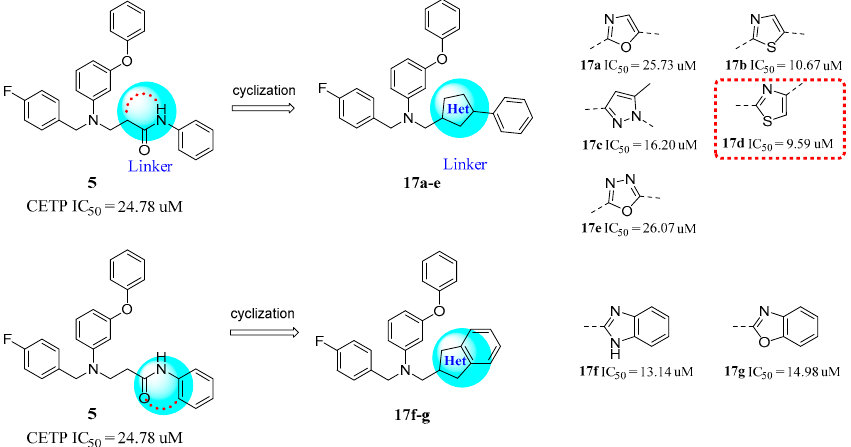
Figure 2. Design of N , N -substituted-aryl-methylamines.